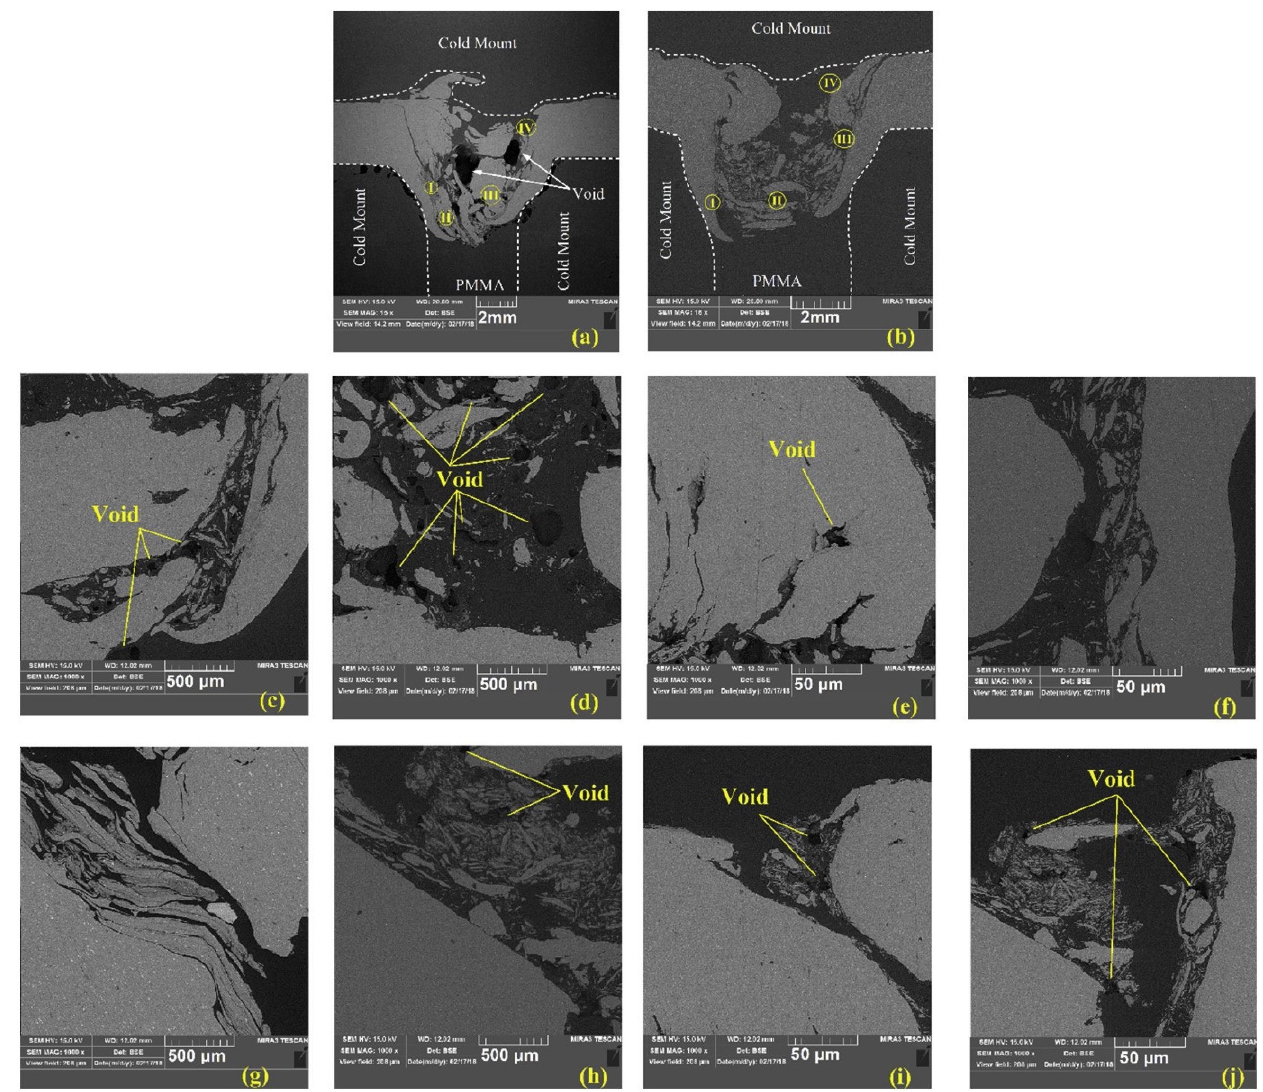
Figure 7. Cross-sectional SEM images of AA6063/PMMA joints. The samples were prepared by ( a ) FSW and; ( b ) FFSW; ( c – f ) shows the details of SZ regions (I-IV) in ( a ) respectfully; ( g – j ) shows the details of SZ regions (I-IV) in ( b ) respectfully. Reprinted with permission from Ref. [76]. 2020, H. Aghajani Derazkola and A. Simchi.